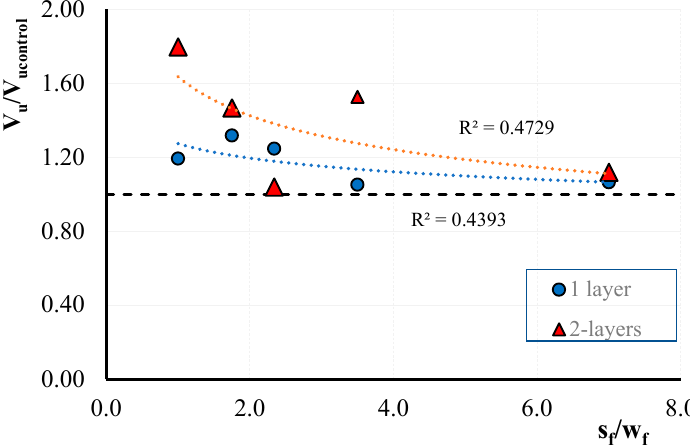
Figure 12. Non-dimensional shear capacity v = V u /V ucontrol versus s f /w f .